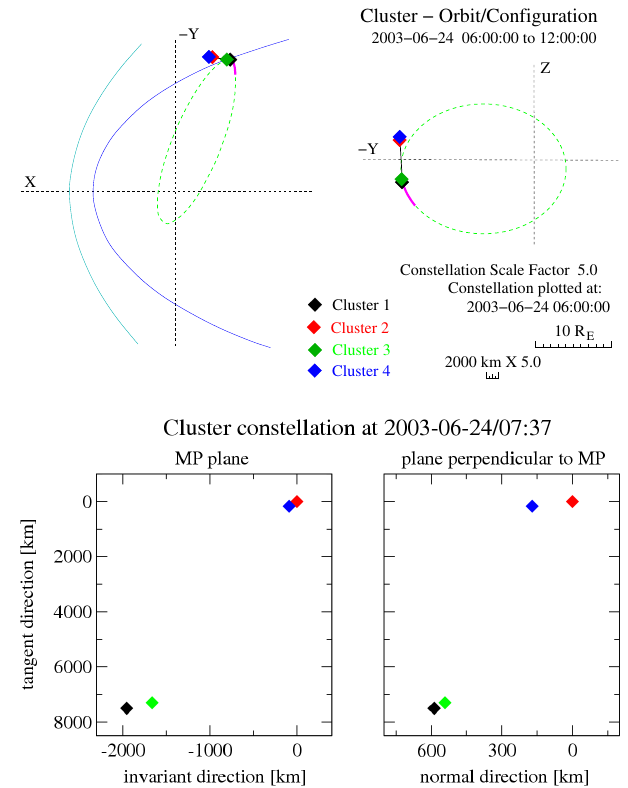
Fig. 1. Upper part: Cluster orbit on 24 June 2003 projected on the XY and ZY planes of the GSE reference system. The distances between satellites, shown in the mission color code, are increased by a factor of 5. Lower part: Projections of Cluster configuration on the MP plane (left) and on a plane containing the MP normal (right), at the time of the event. More details are given in the